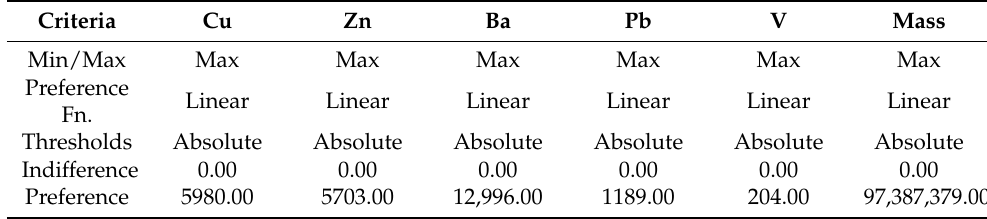
Table 4. Preference parameters for Scenario